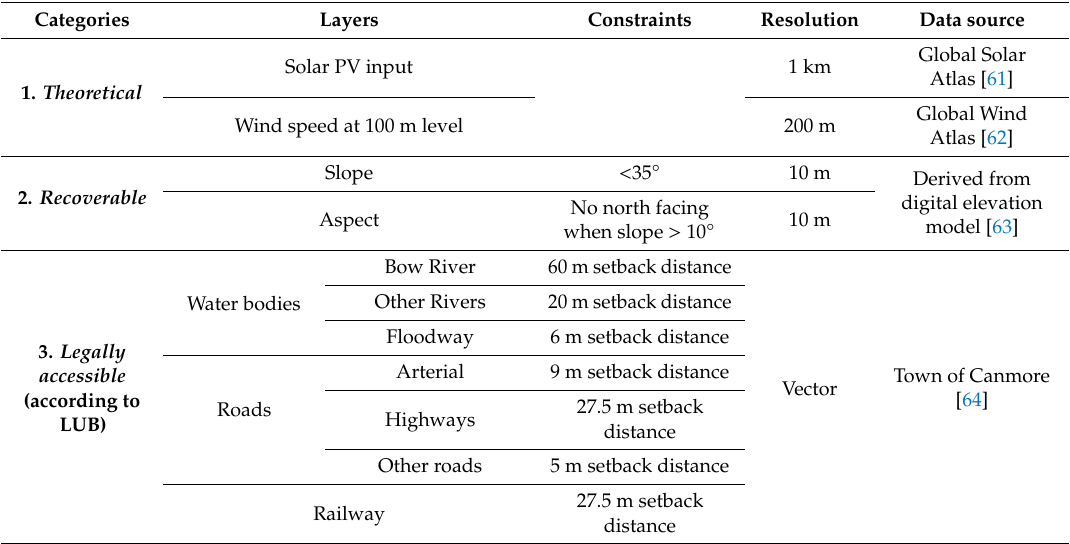
Table 1. Accelerating Implementation of Renewable Energy (AI-RE) data table for 4 di ff erent categories.